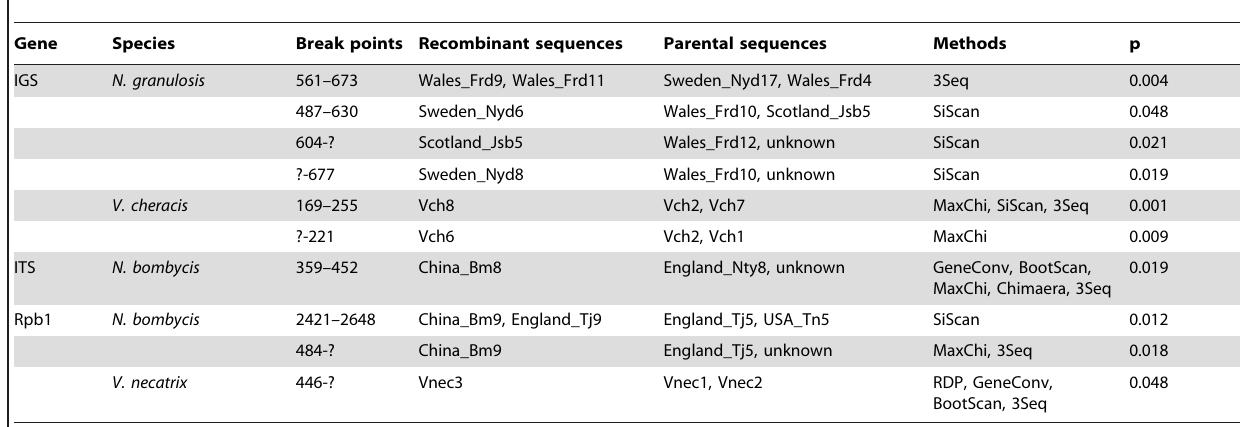
Table 3. Recombination events detected in alignments of cloned sequences using RDP4.